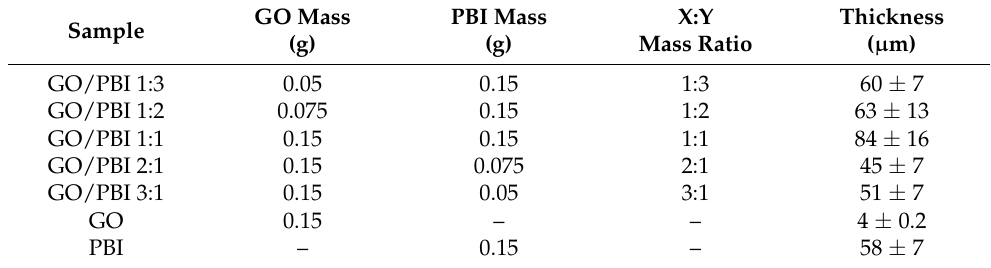
Table 1. Preparation quantities of GO, PBI, and corresponding solutions, X:Y mass ratios, and average thicknesses of the GO/PBI X:Y composite membranes. Data of the benchmark GO and PBI membranes are reported for